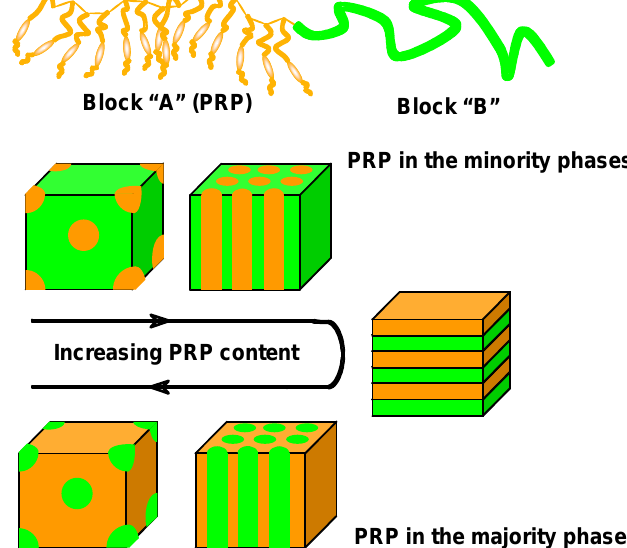
Figure 1. Microphase separation of AB-type PRBCs with well-defined